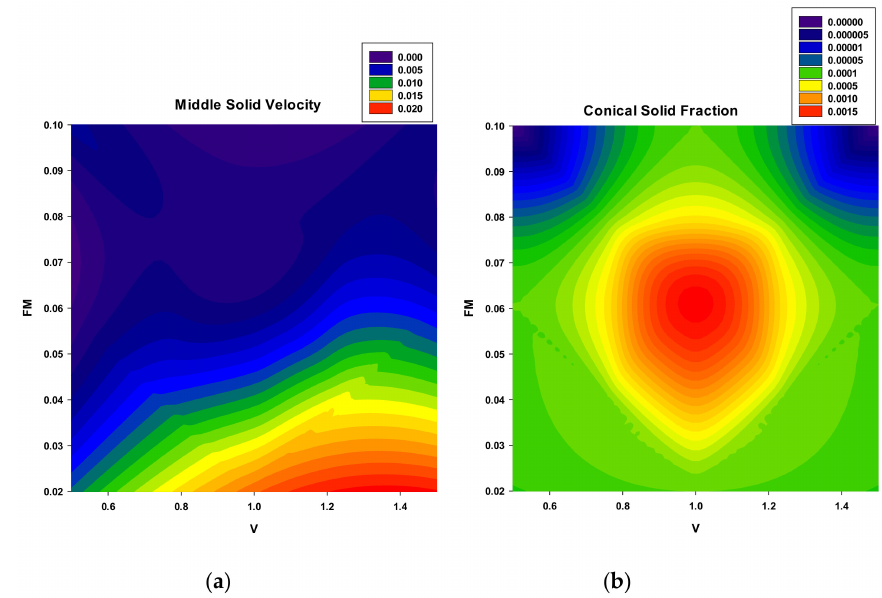
Figure 9. ( a ) middle solid velocity and ( b ) conical solid fraction on 2D plots as a function of feed gas velocity and mixing particle